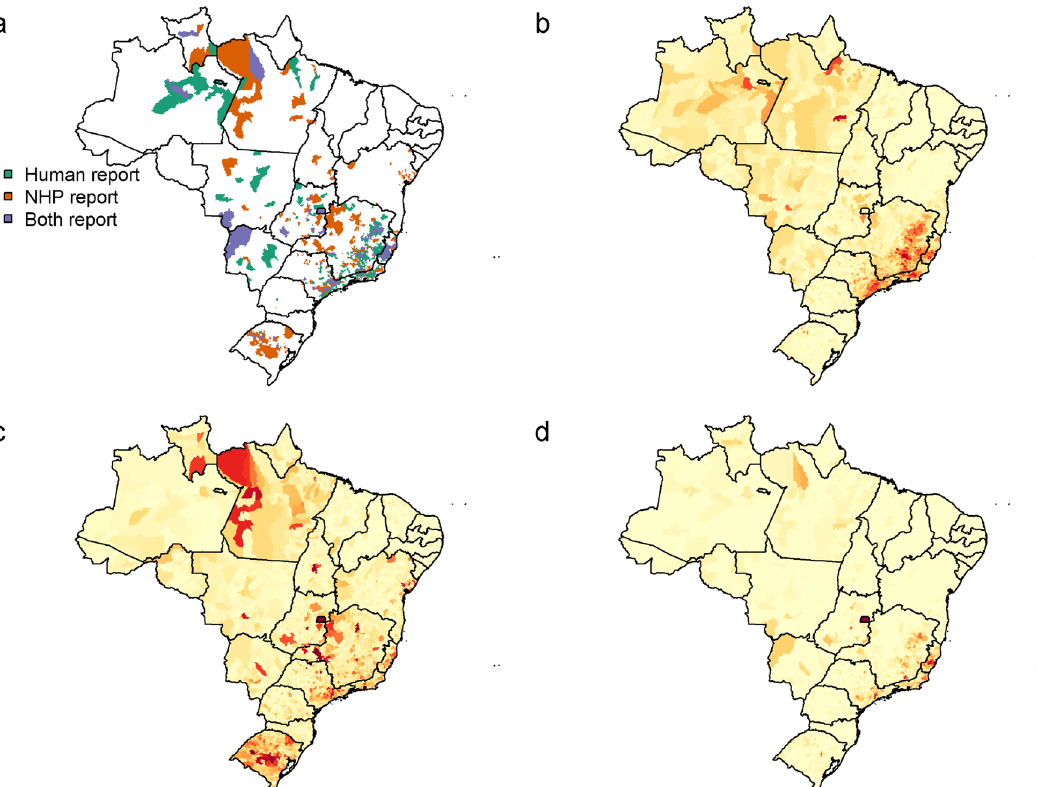
Fig. 4 Data and predictions of YF cases in humans, NHPs and both across Brazil. A Aggregate reports of the data for human, NHP and both reports model predictions for the probability of classifying an administrative location as A only having human reports, C only NHP reports and D both human and NHP reports. Model predictions are from the best fi t model with all covariates (model OHAC). Colours indicate the probability of presence for each of the report type in fi gures B – D